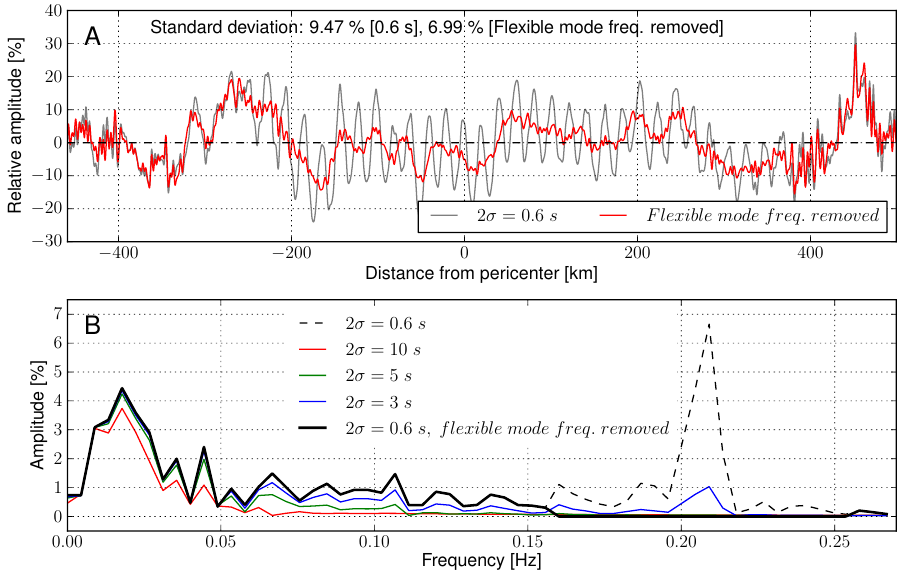
Figure 4. ( A ) The relative perturbations of the filtered acceleration (2 σ = 0.6 s) with respect to the seventh-order polynomial fit before (black) and after (red) removing the frequencies around the first flexible mode. ( B ) The frequency spectra of the relative acceleration perturbations obtained with filters of different widths: 2 σ = 0.6 s (dashed black line), 2 σ = 0.6 s after FFT filtering (thick solid black line), 2 σ = 3 s (blue), 2 σ = 5 s (green), and 2 σ = 10 s (red). Note how increasing σ affects the frequency spectrum apart from the flexible